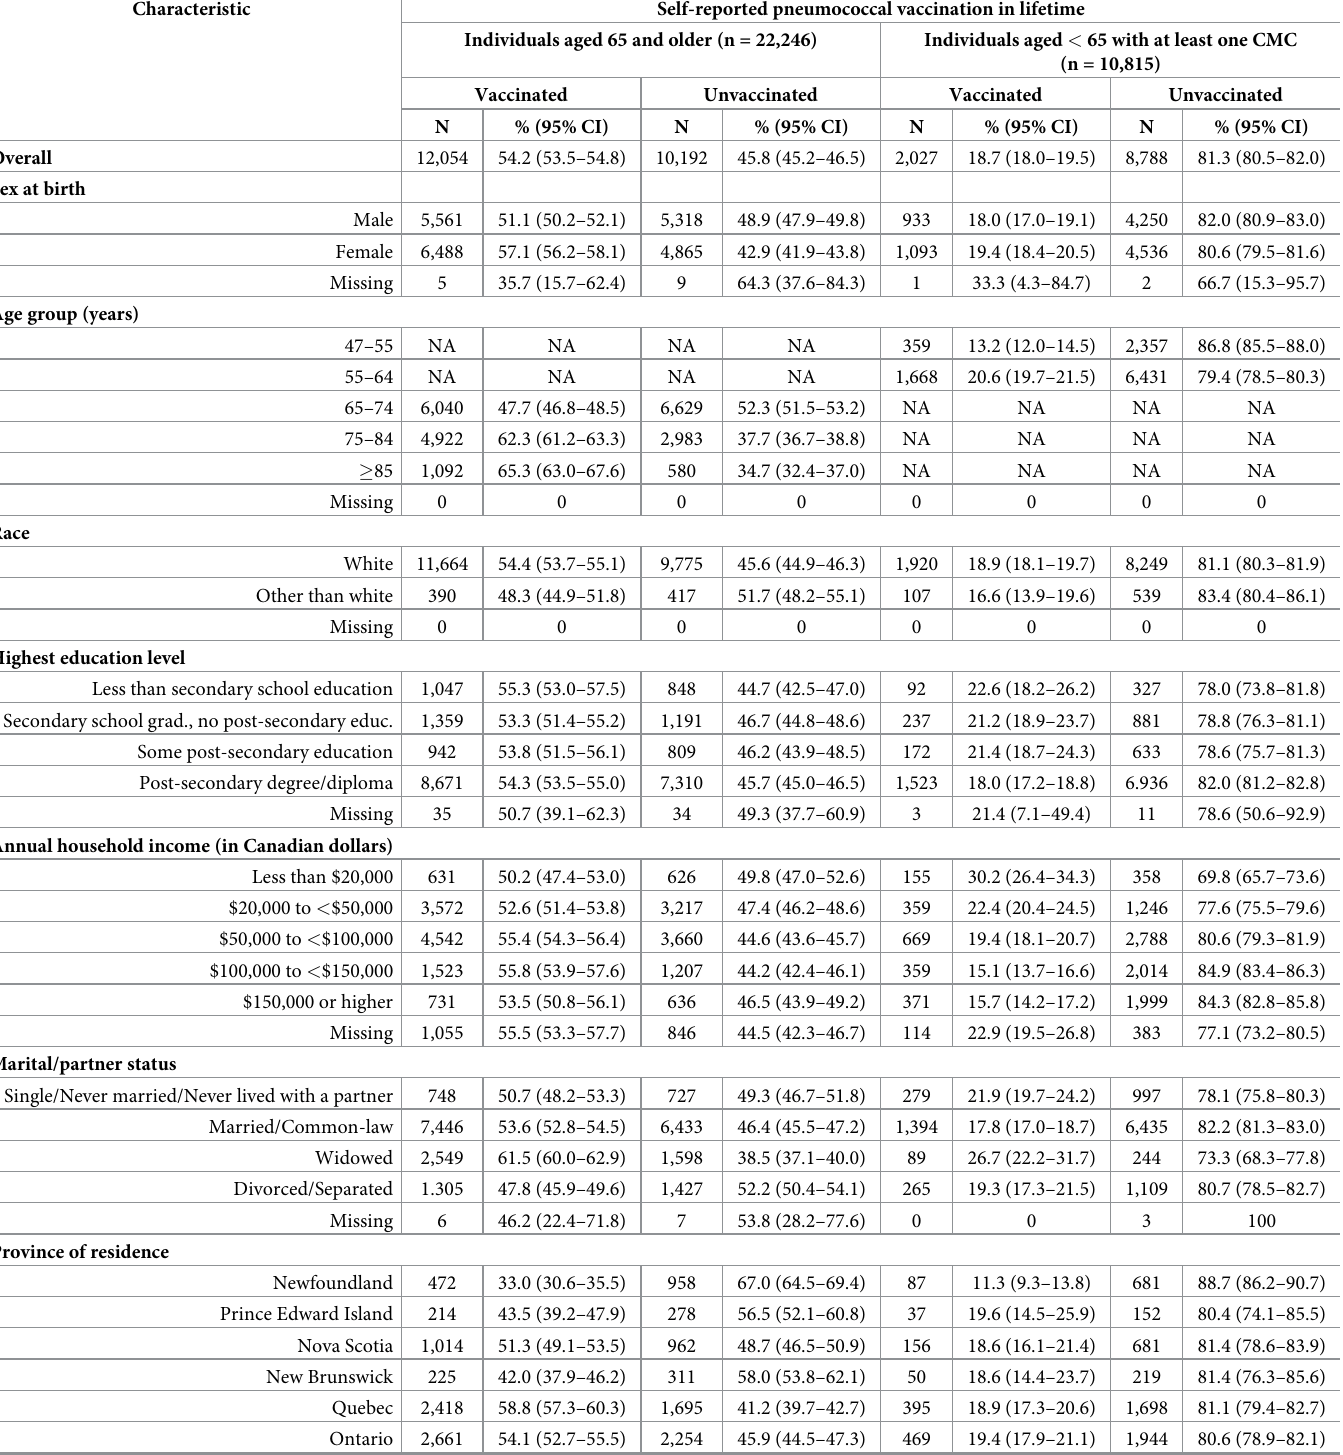
Table 1. Self-reported pneumococcal vaccination status (vaccinated or unvaccinated during lifetime) among Canadian Longitudinal Study on Aging (CLSA) cohort participants who were considered eligible to receive a pneumococcal vaccine as per Canada’s National Advisory Committee on Immunization (NACI) guidelines, by key sociodemographic